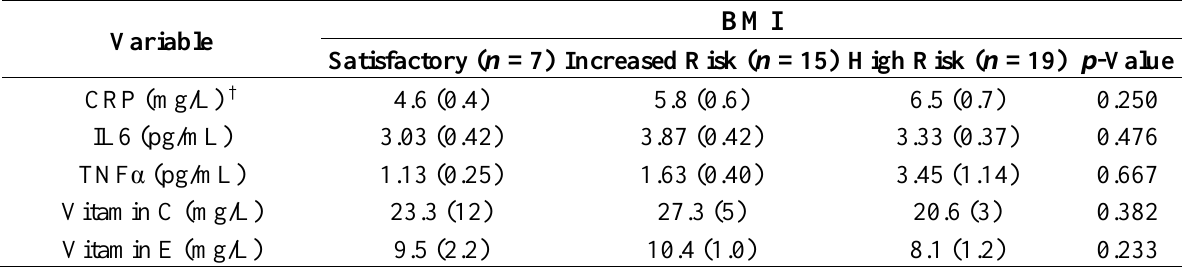
Table 2. Antioxidants and markers of oxidative damage and inflammation according to the WHO BMI cut-off-points for male subjects (mean